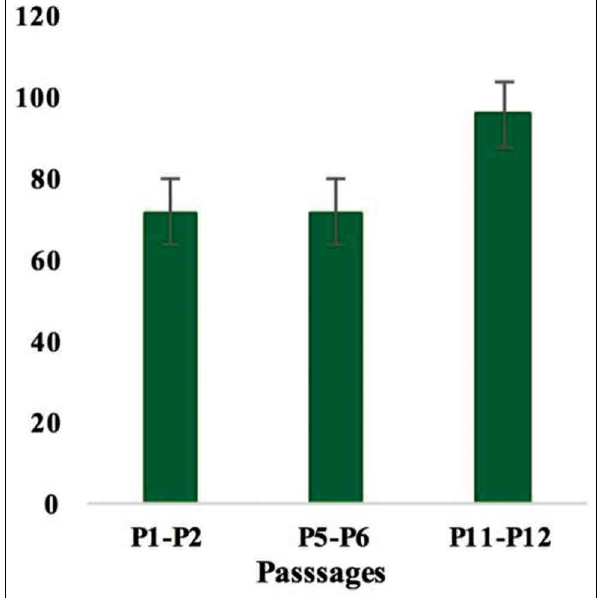
Figure-6: PDT of BMMSCs in P1-P2, P5-P6, and P11-P12 were recorded. PDT significantly higher in P11-P12 than that in other passages. Error bars represent Mean ± SE. PDT=Population doubling time, BMMSCs=Bone marrow mesenchymal stem cells.